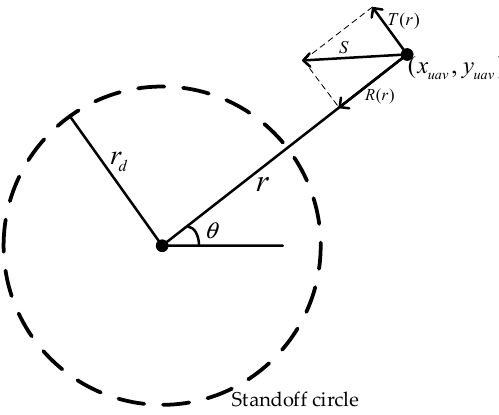
Figure 3. Construction component and circulation component.